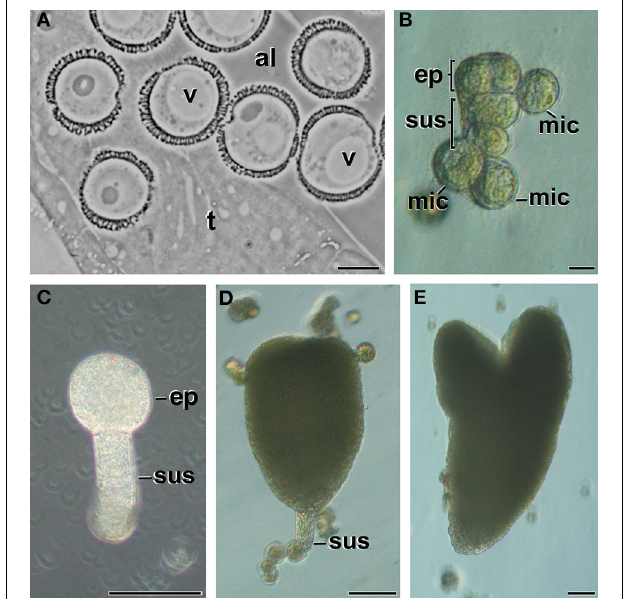
FIGURE 1 | Stages of B. napus microspore embryogenesis. (A) Vacuolate microspores during in vivo development within the anther. (B) Just induced, embryogenic microspore showing two clearly differentiated domains, the embryo proper domain (ep) and the suspensor (sus). Other microspores (mic) are not sensitive to induction and become arrested or enter a pollen-like development. (C) Globular MDE. (D) transitional MDE. (E) Torpedo MDE. al, anther locule; t, tapetum; v, vacuole. Bars: (A,B) : 10 μ m, (C–E) : 50 μ